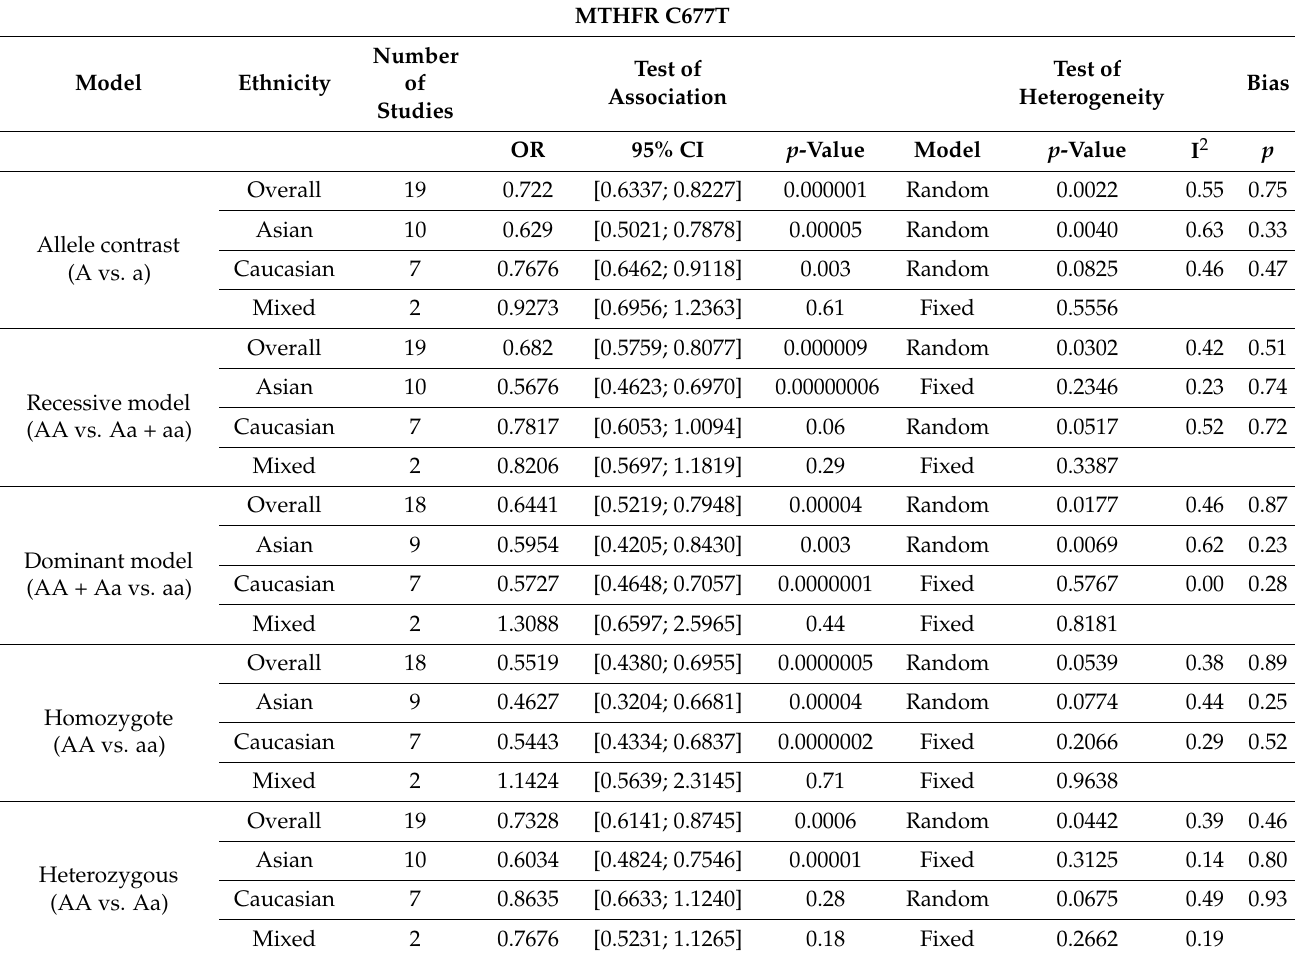
Figure 5. ( A ) Allele model for RFC; Marco [25], Relton [28], Pei [67], Cao [68] ( B ) Dominant model for RFC; ( C ) Homozygote model for RFC; ( D ) Heterozygous model for RFC. Table 1. Subgroup analysis using 5 genetic models. Model Code: R = Random, F = Fixed. MTHFR